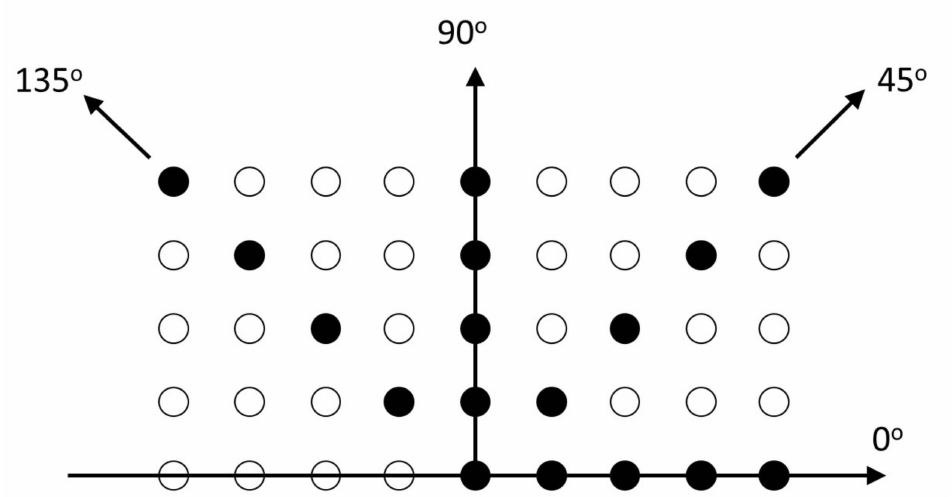
Figure 1. Directions of analysis in the gray level coexistence matrix.